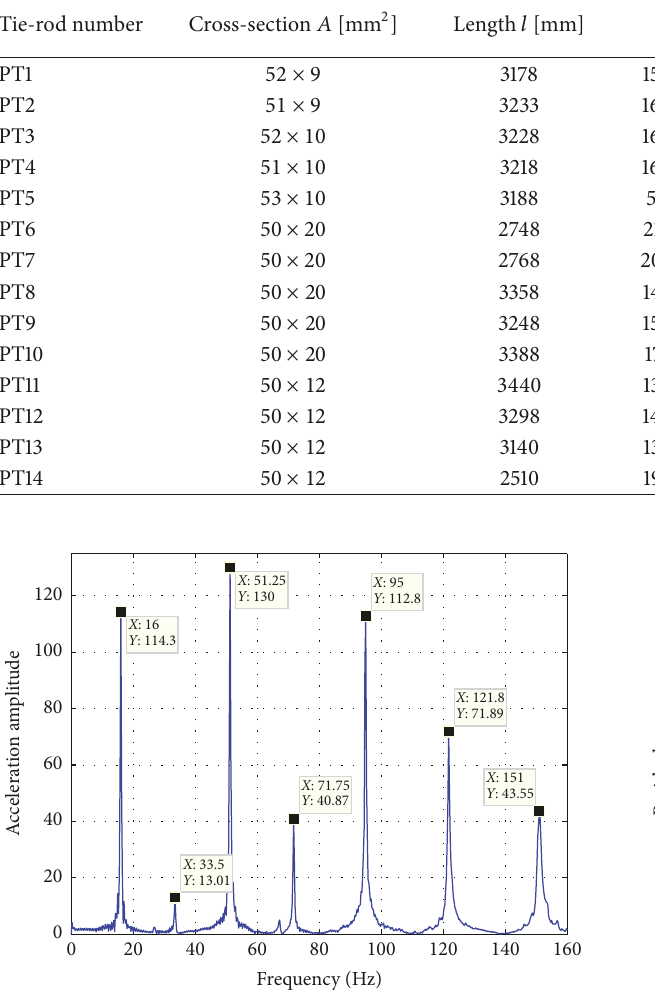
Figure 5: FRF plot (acceleration amplitude versus frequency). Figure 6: Residual error function as function of elastic bed stiffness and axial